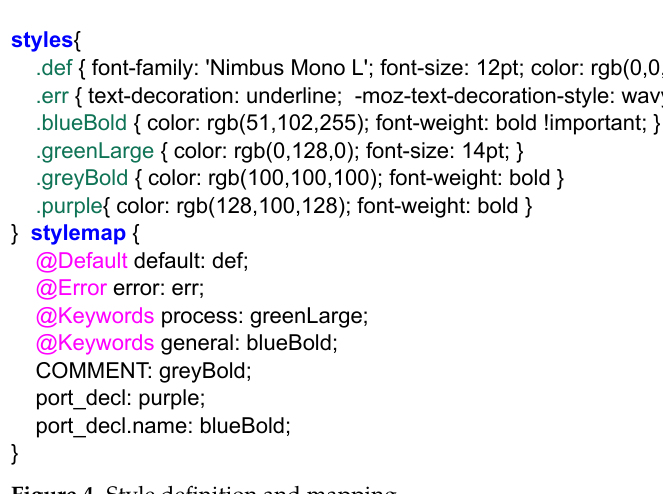
Figure 4. Style definition and mapping.